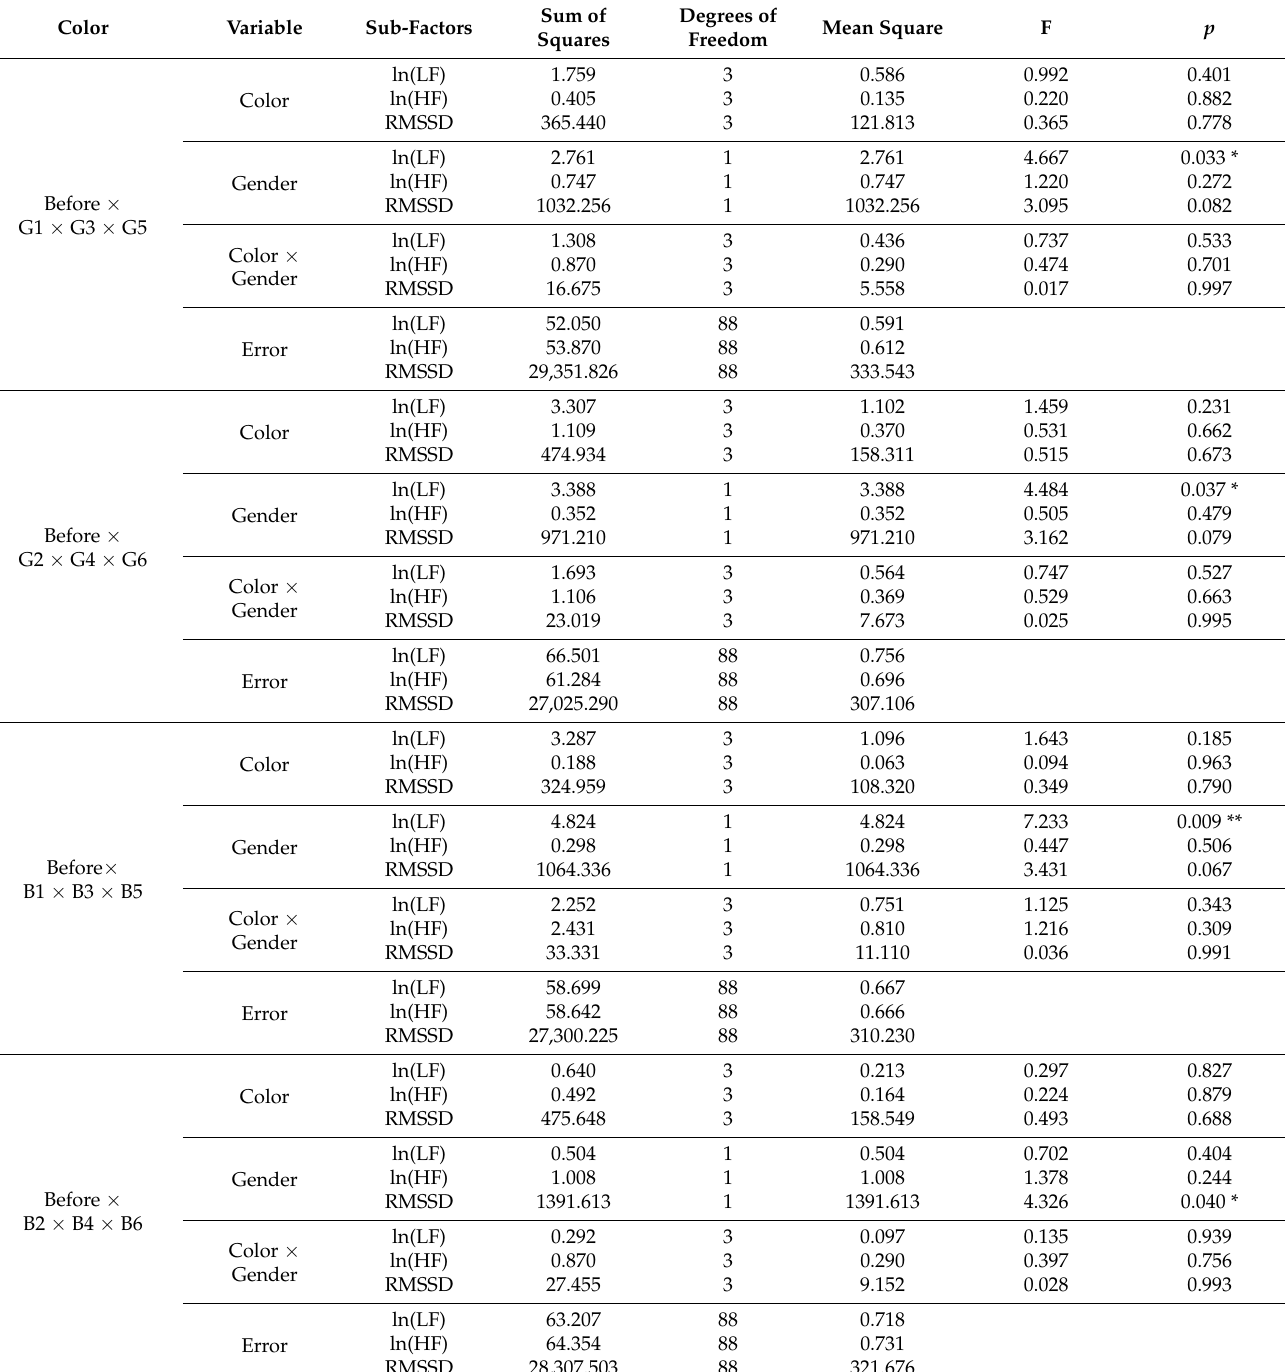
Table 8. Effect and interaction by chroma changes and gender for ln(LF), ln(HF), and